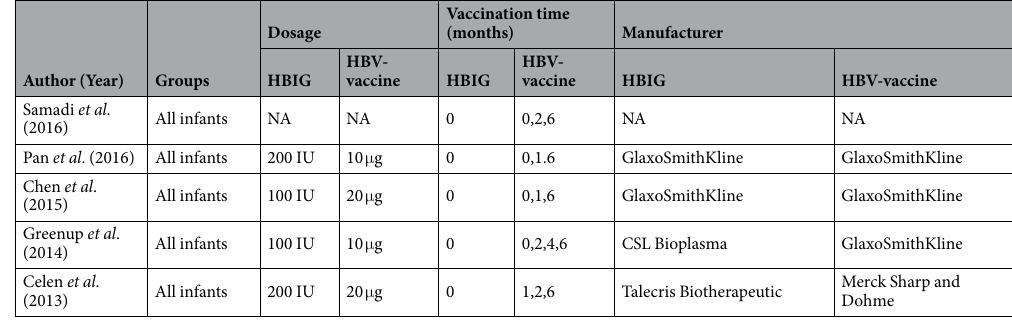
Table 2. Baseline information for HBIG + HBV vaccine given to infants in the 5 included studies. Abbreviations: HBIG, hepatitis B immune globulin; NA, not